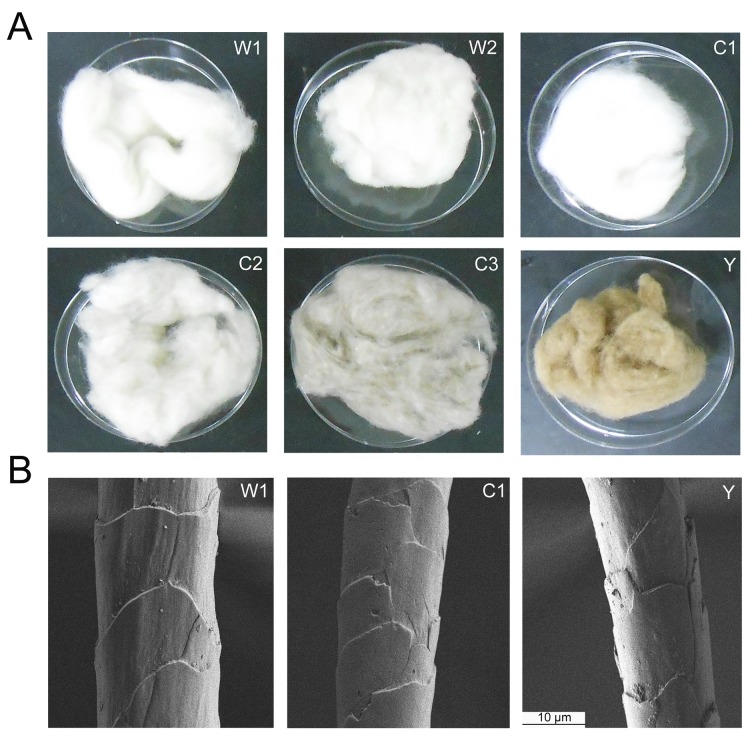
Animal hair fiber standards involved in our proteomic study.(A) Appearance inspection of different fiber standards including two breeds of wool (W1, W2), three breeds of cashmere (C1, C2, C3) and one breed of yak (Y) as specified in Experimental Section. (B) Scanning electron microscopy (SEM) analysis of the fine morphology of different fibers.